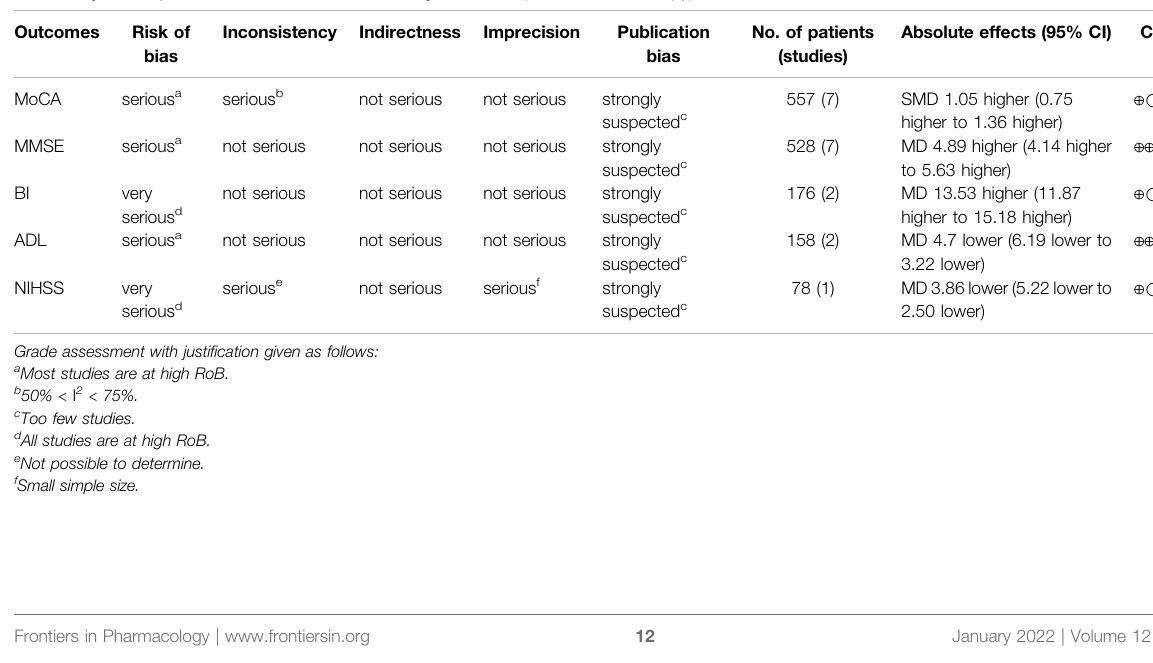
TABLE 2 | Certainty assessment of evidence according to GRADE (NBP as monotherapy).